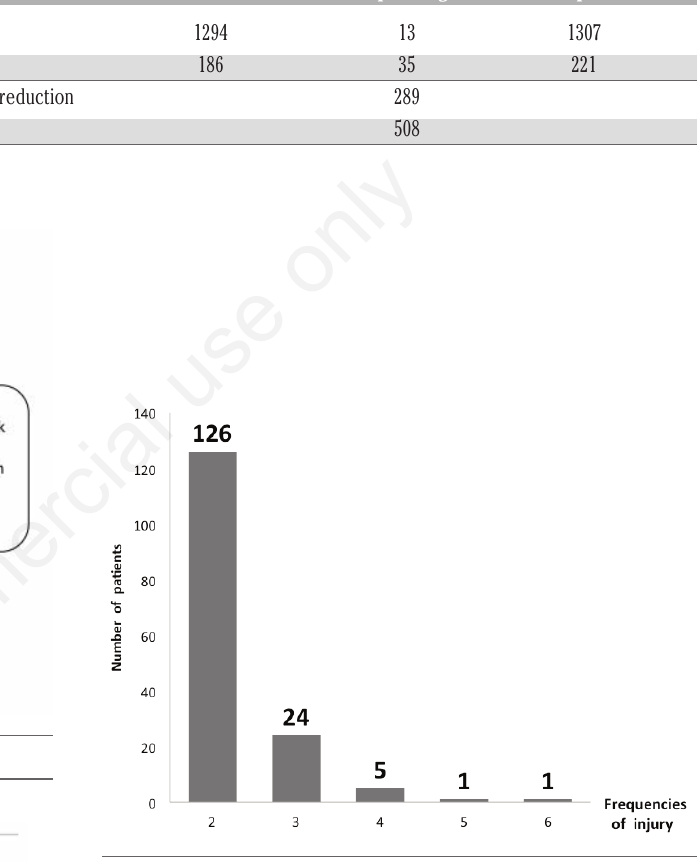
Figure 3. Frequencies of injury caused by pulled elbow per patient who had an injury more than once.